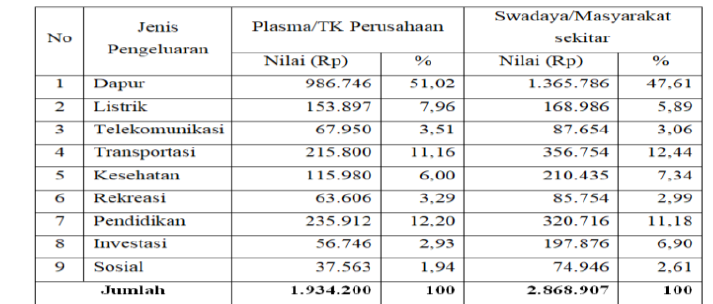
Table 1: Average types of routine community expenditure around private oil palm